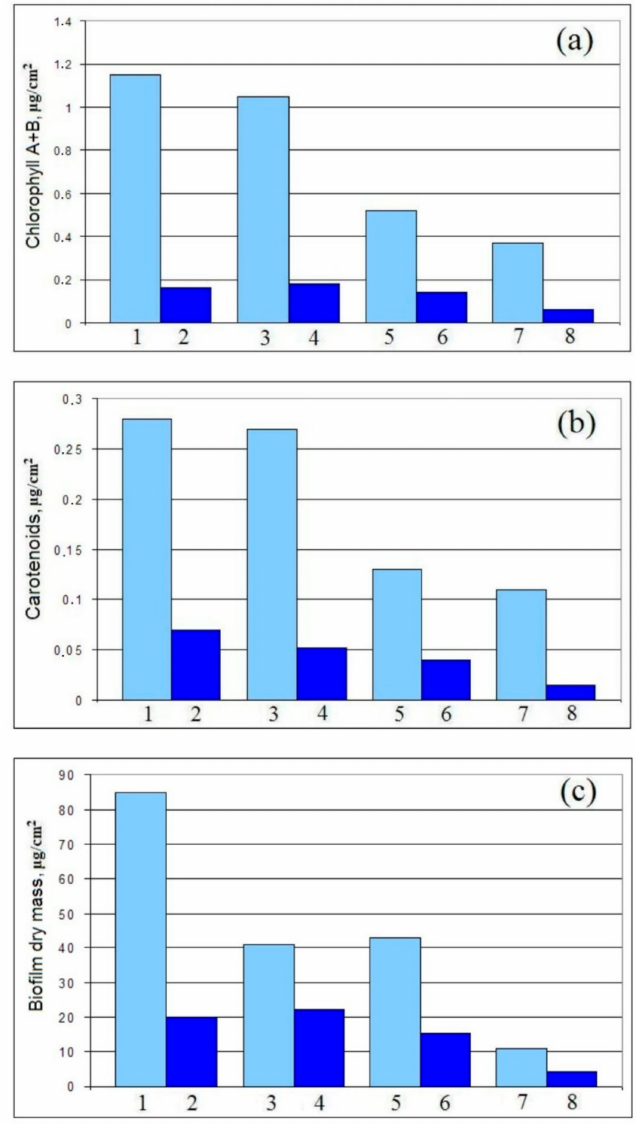
Figure 6. Total chlorophyll ( a ), carotenoids content ( b ) and dry mass ( c ) of biofilm formed on coatings cross-linked with ES40 (columns 1, 3, 5, 7) or with ES 40 and 2 wt % PEG-silane (columns 2, 4, 6 and 8) without additives: columns 1 and 2, or containing: 0.5 wt % NIS (columns 3 and 4); 2.0 wt % AO (columns 5 and 6); 0.5 wt % NIS and 1.5 wt % AO simultaneously (columns 7 and